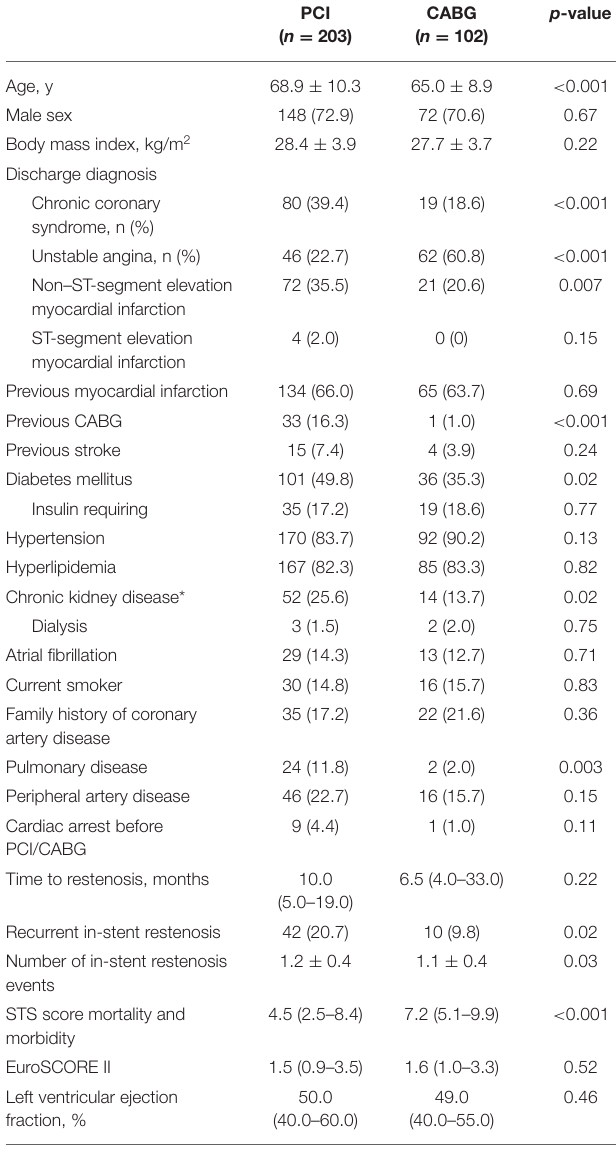
TABLE 1 | Patient characteristics, risk factors, and clinical presentation according to the type of